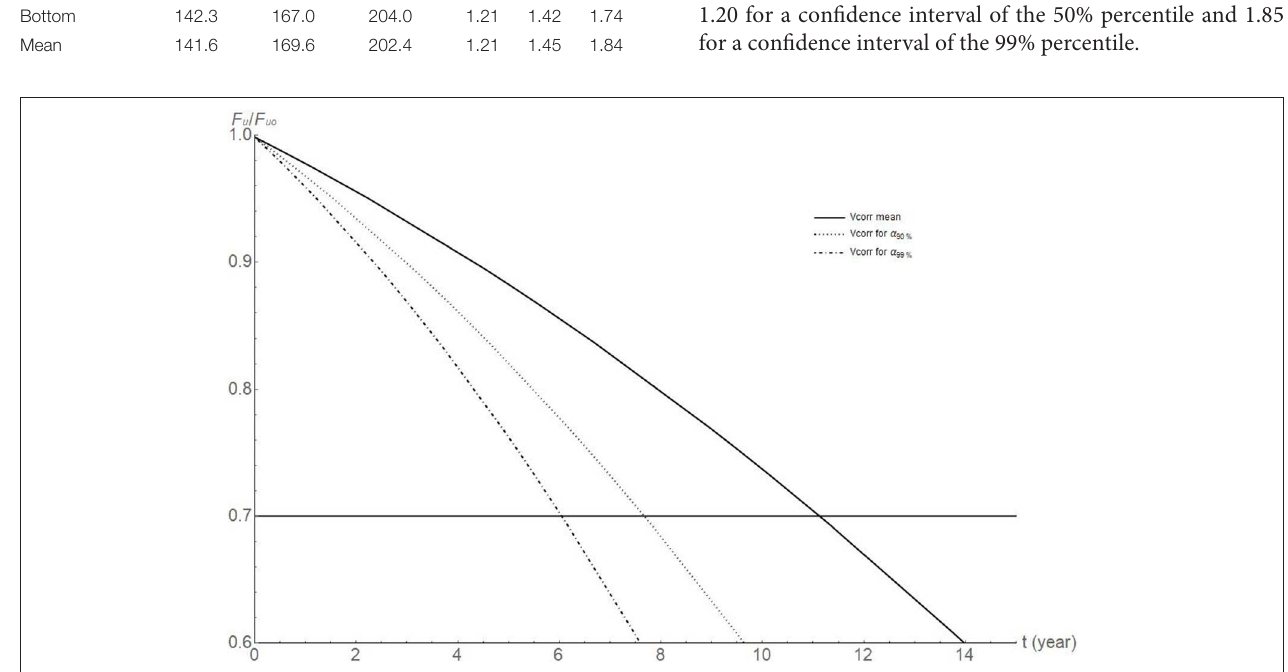
FIGURE 10 | Durability